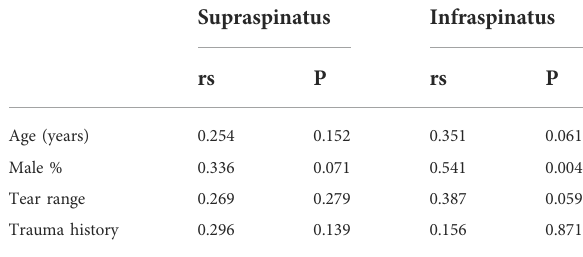
TABLE 3 Correlation analysis of the average Goutallier grade of supraspinatus and infraspinatus in the L-shaped tear group.